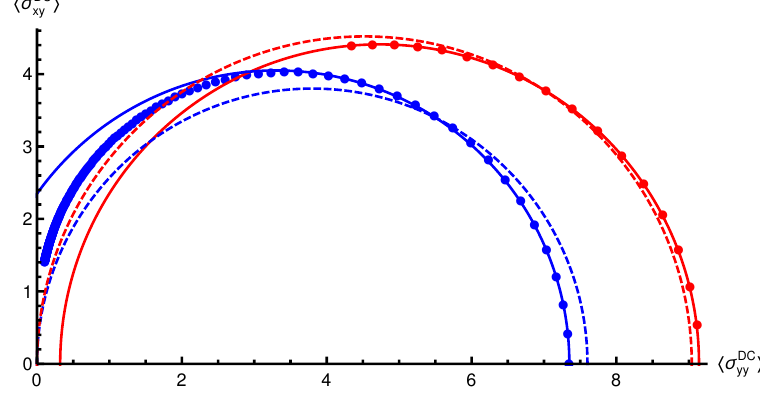
Figure 2 . The semi-circle law for the DC conductivities. The homogenous phase is shown in blue and the striped phase in red. For the striped phases the spatially averaged conductivities h σ DC and h σ DC i are plotted. The dots are the numerically computed data points at µ = 4 . The dashed yy lines illustrate a semi-circular fit constrained to go through the origin, while the solid curve is a semi-circular fit of the low- b data